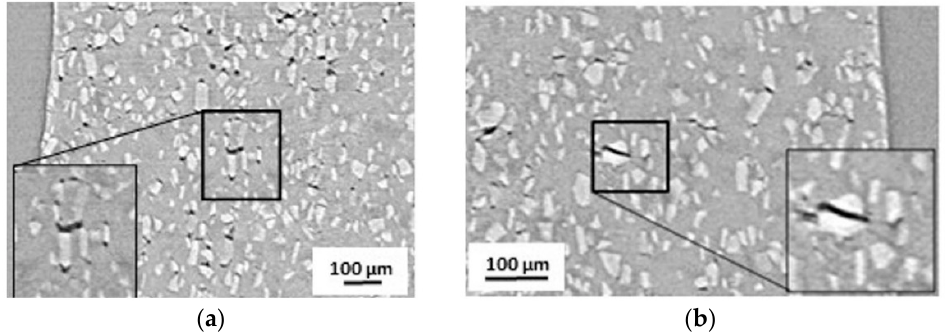
Figure 8. Creep damage: ( a ) surface diffusion at 0.98 𝑡 (cid:3033)(cid:3045) ; ( b ) particle fracture at 0.96 𝑡 (cid:3033)(cid:3045) .